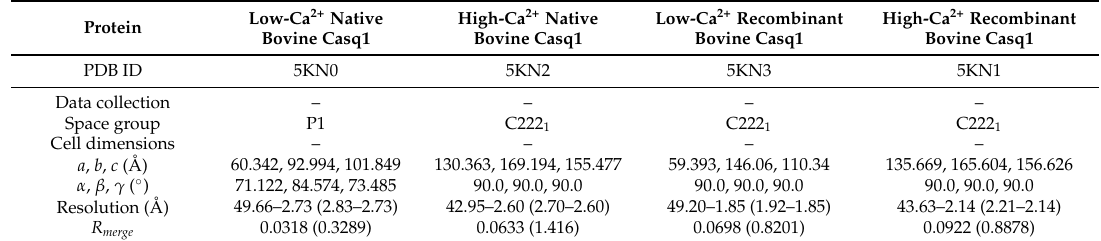
Table 3. X-ray data collection and refinement statistics. TLS,